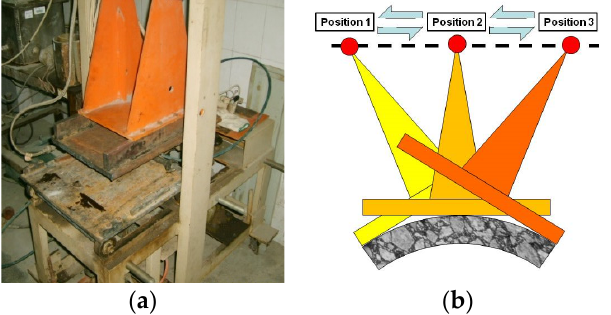
Figure 4. The forming machine for an arc-shaped specimen: ( a ) machine after updating and ( b ) specimen molding process diagram.